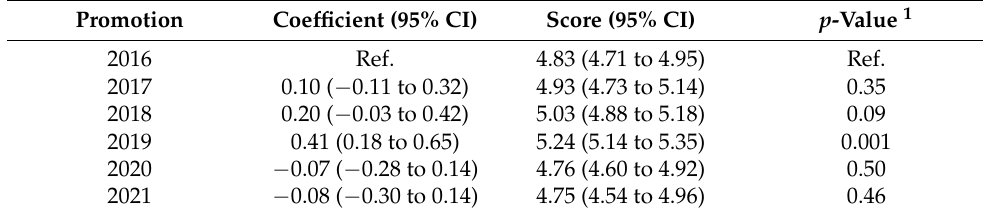
Table 2. Examination score by promotion, calculated by linear regression, and expressed as mean (95%CI). Promotion Coefficient (95% CI) Score (95% CI)